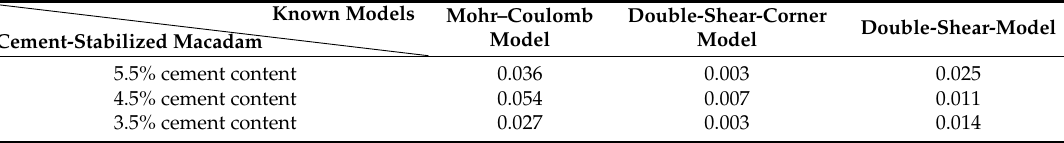
Table 8. The residual sum of squares between g ( θ ) from test data and from three known models. Cement-Stabilized